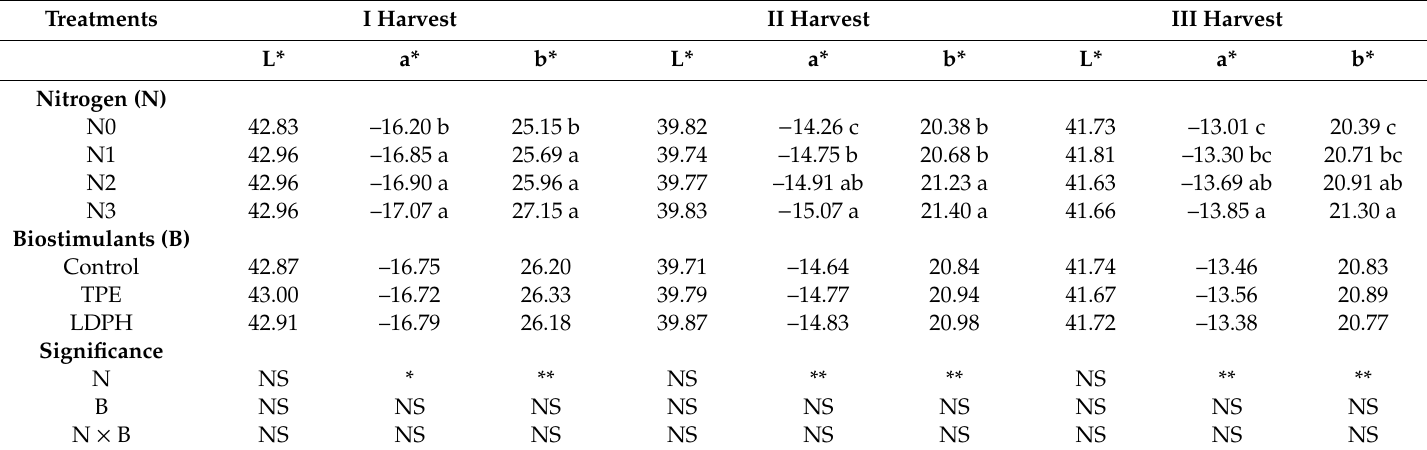
Table 4. Baby rocket leaf plants hunter color parameters (L*, a*, and b*) at di ff erent harvest dates in relation to N fertilization rates (N0 = 0, N1 = 60, N2 =